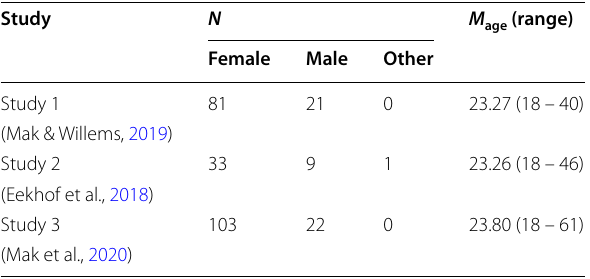
Table 1 Sample information for the three studies